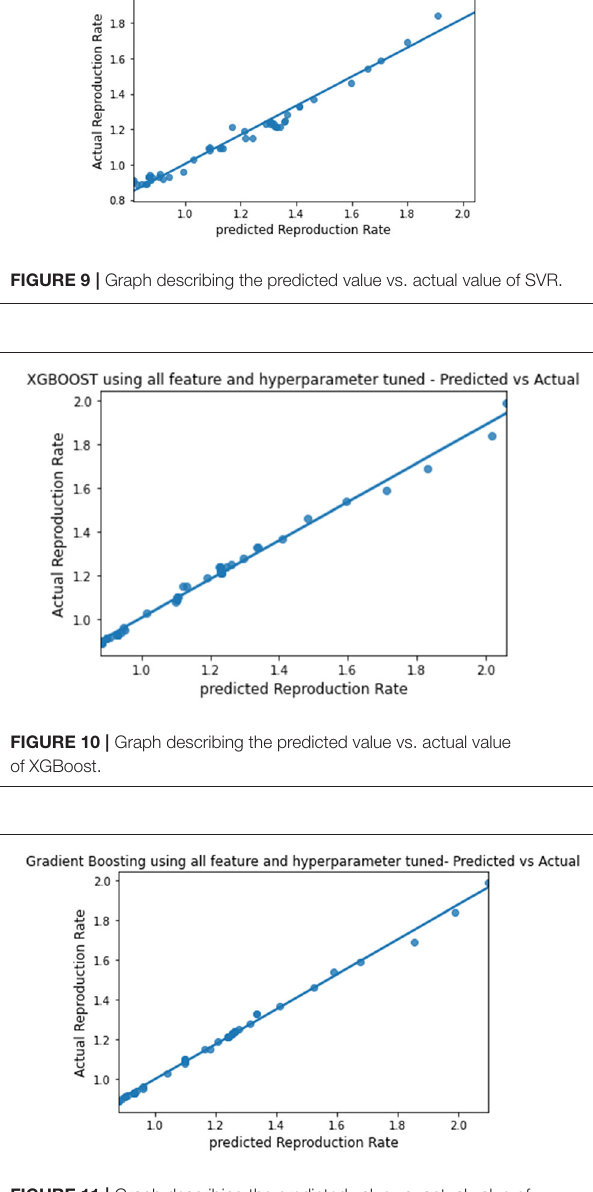
FIGURE 11 | Graph describing the predicted value vs. actual value of Gradient